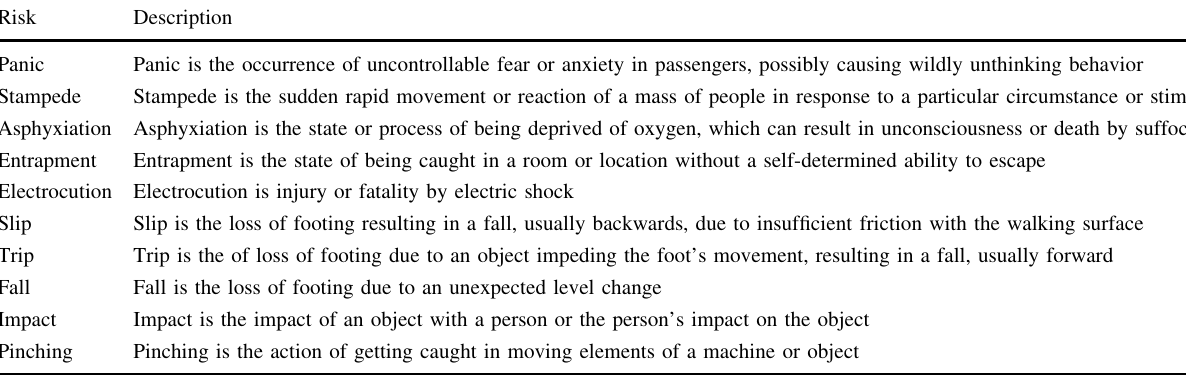
Table 1 Relevant risk exposures in this